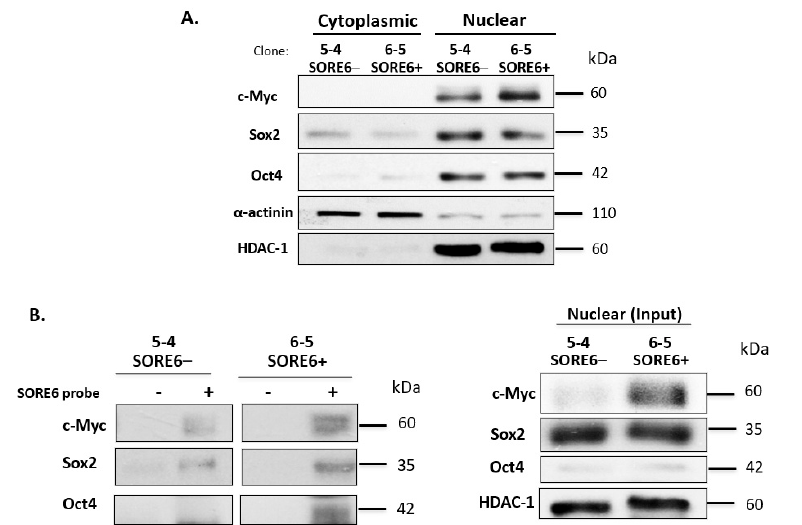
Figure 6. SORE6 − and SORE6+ clones are biochemically distinct. ( A ) The subcellular localization of Sox2, Oct4, and c-Myc in SORE6 − and SORE6+ cells derived from SupM2, assessed by the nuclear cytoplasmic fractionation assay. ( B ) The DNA pull-down assay was performed to assess Sox2, Oct4, and c-Myc transcriptional activity in SORE6 − and SORE6+ cells using a biotin-labeled SORE6 probe.